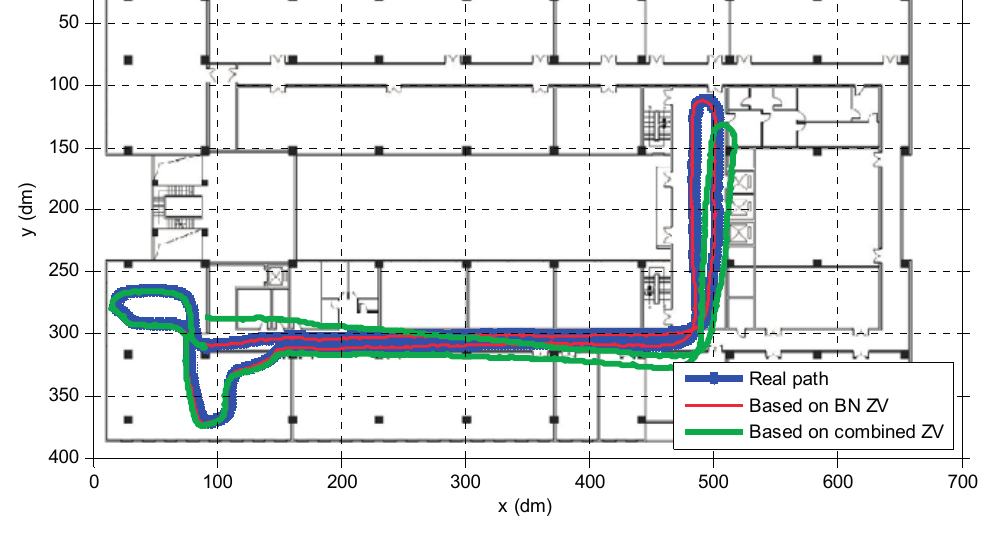
Figure 16. Estimated indoor 2D path.